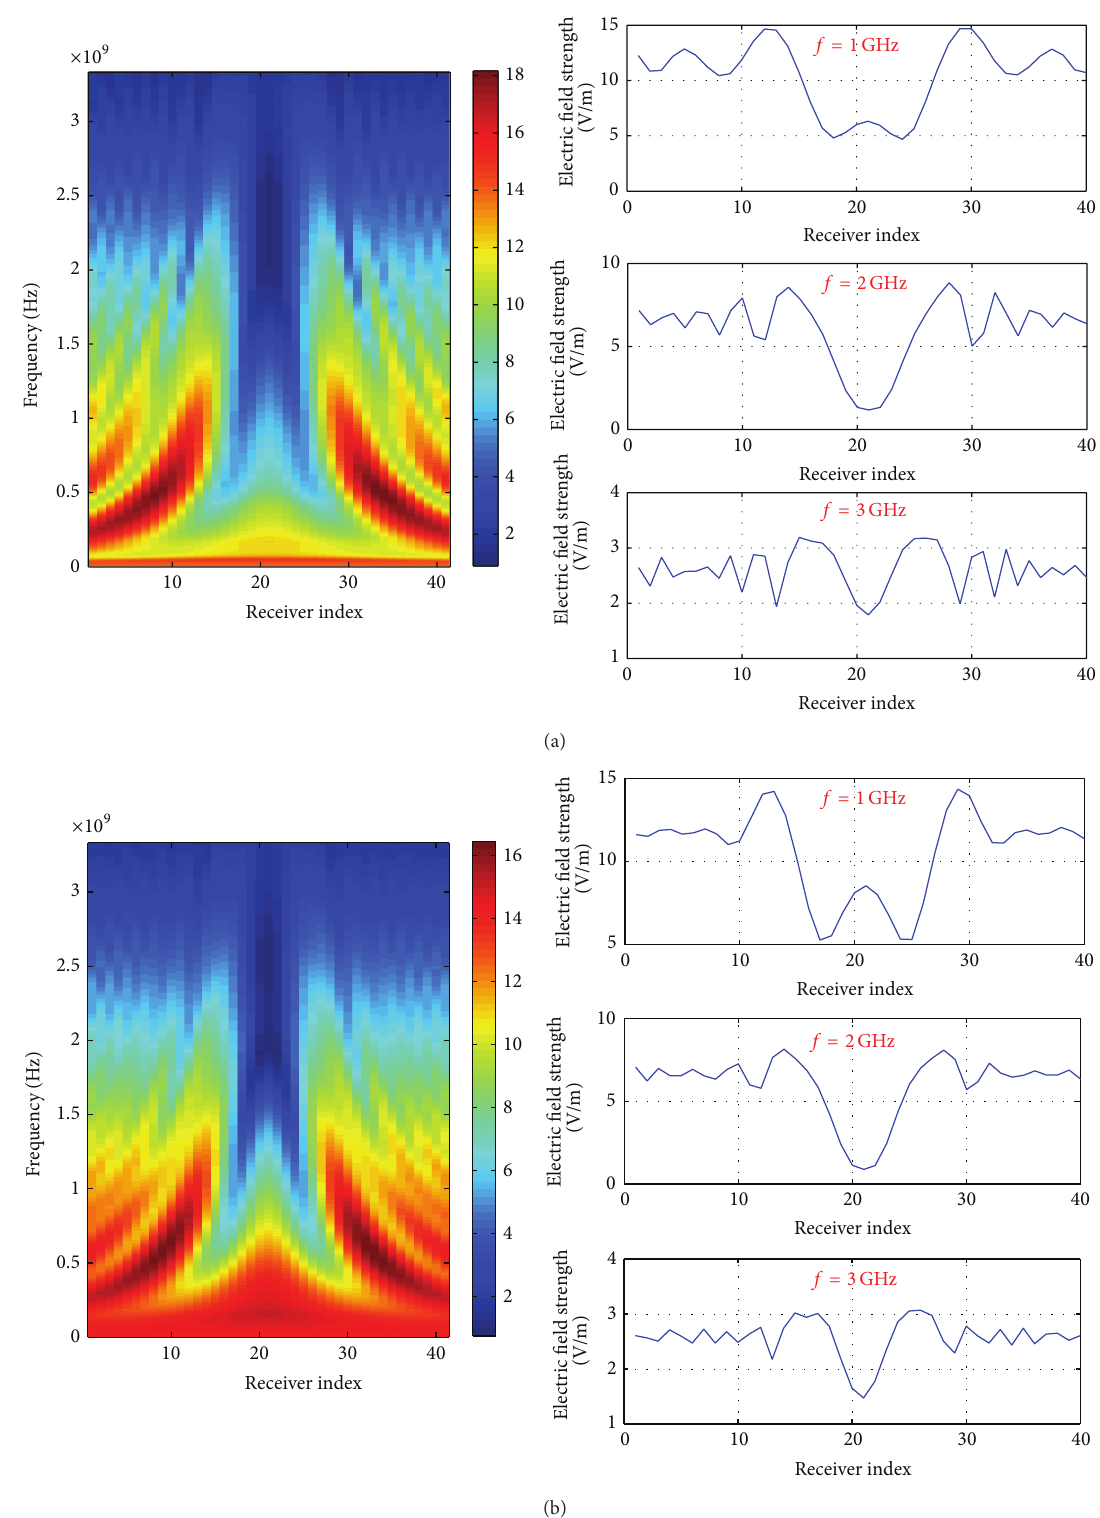
Figure 6: There are two subplots in each figure. Left: received electronic field strength for all the receivers with frequency up to 3.3 GHz; right: electronic field strength for all the receivers at three separated frequencies: 1GHz, 2 GHz, and 3GHz. (a) V-V polarization. (b) H-H